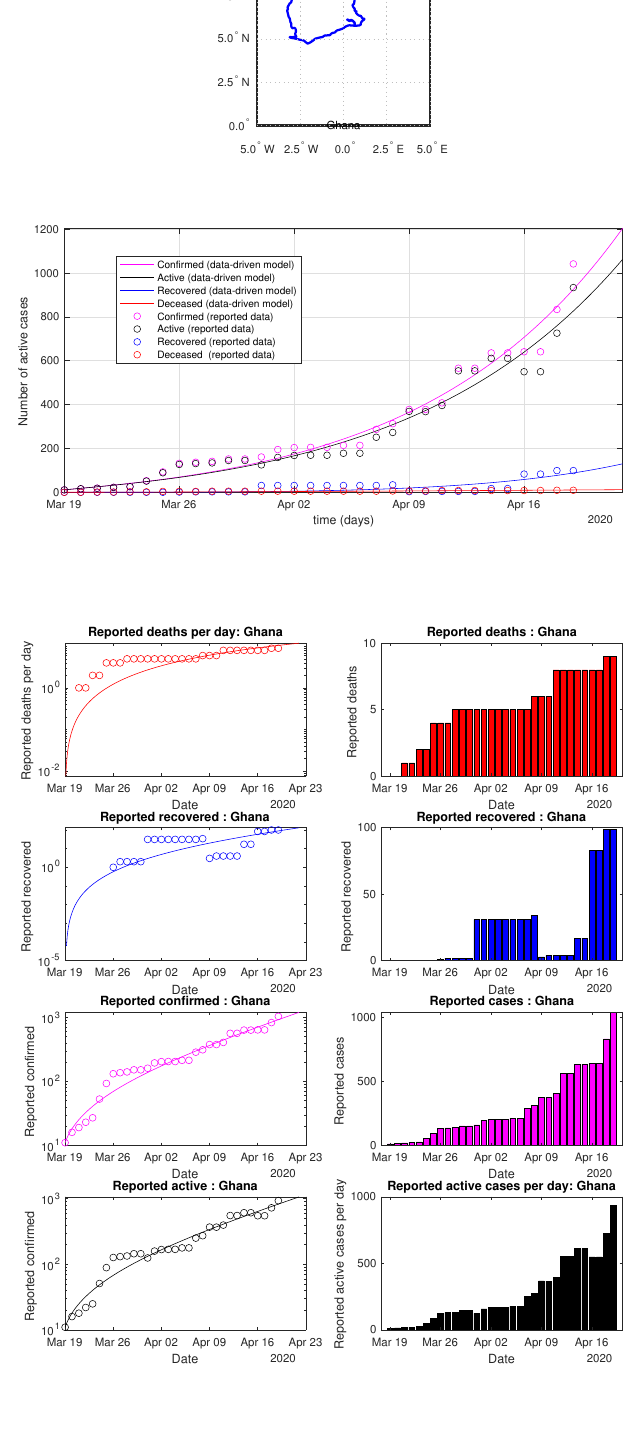
Figure 64. Ghana: data vs.